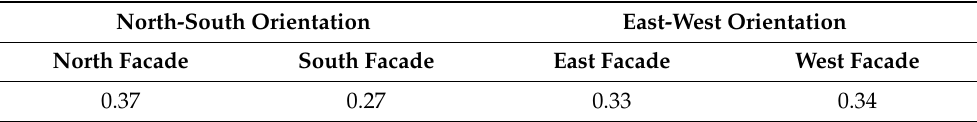
Table 1. Optimal WWR, varying the orientation of the building’s two main facades [58,61– 63].